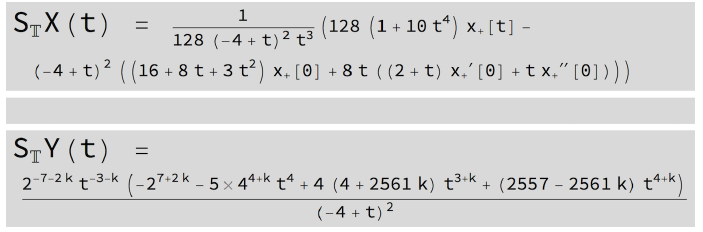
Figure 3. Output given by the [SInt]